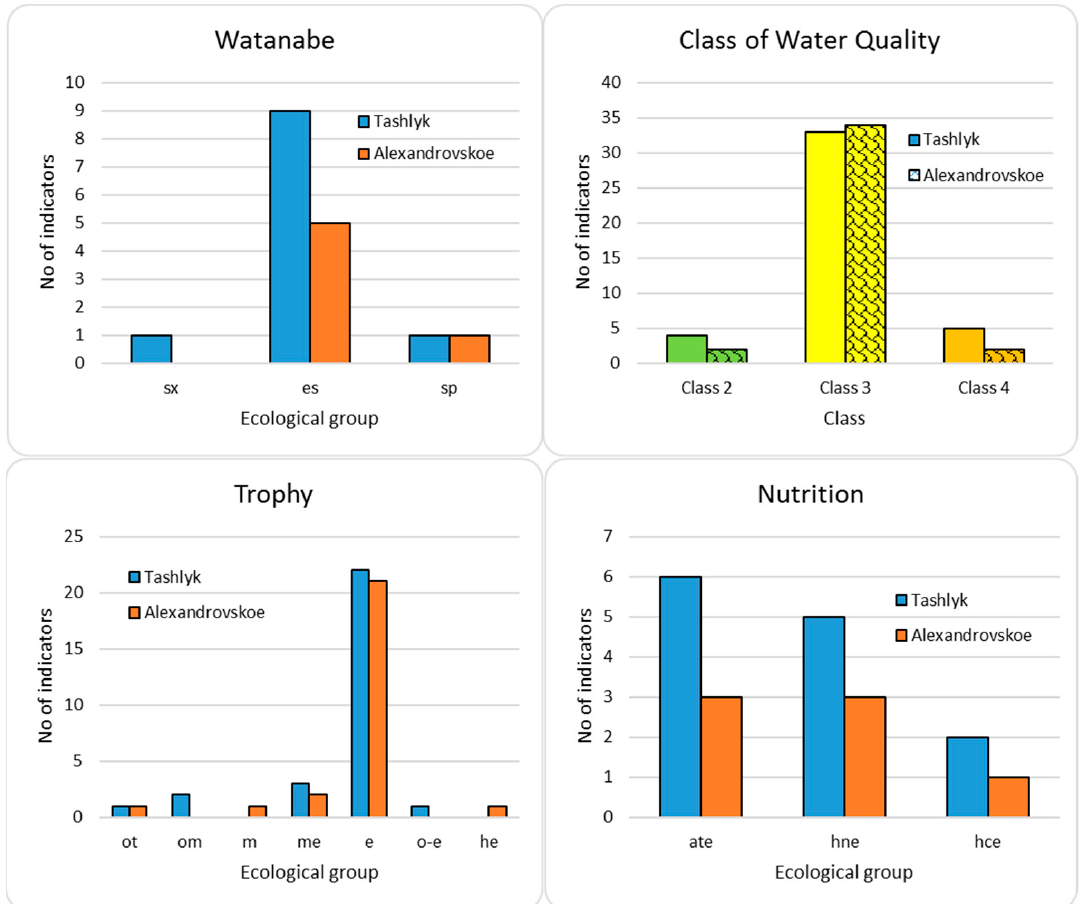
Figure 8. Distribution of indicators of organic pollution according to Watanabe, class of water quality, trophic state and nutrition type for phytoplankton communities in the Tashlyk and Alexandrovskoye reservoirs. Ecological groups on the x -axis are placed in order of increasing indicator variable value. Classes of water quality colored in EU color code. Abbreviations of ecological groups are given in Table 3.